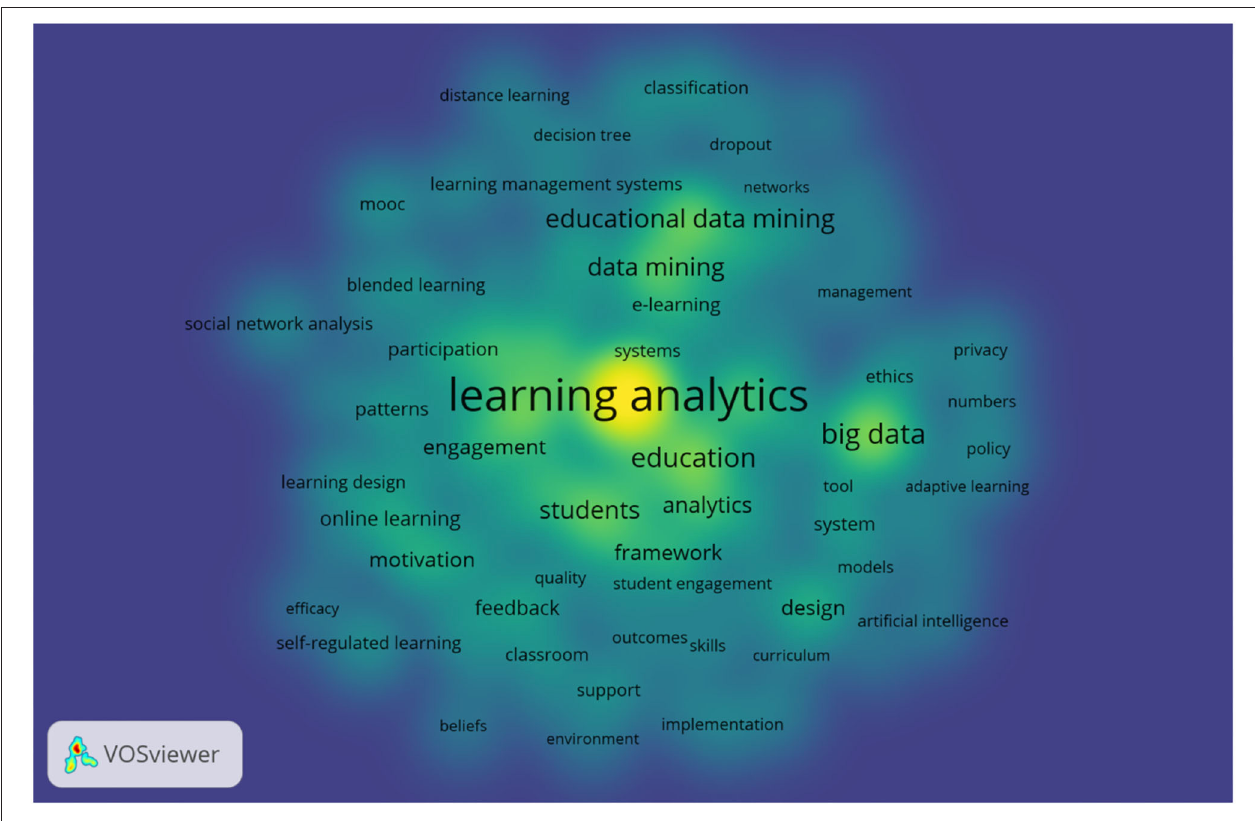
FIGURE 6 | Keywords density visualization of big data in